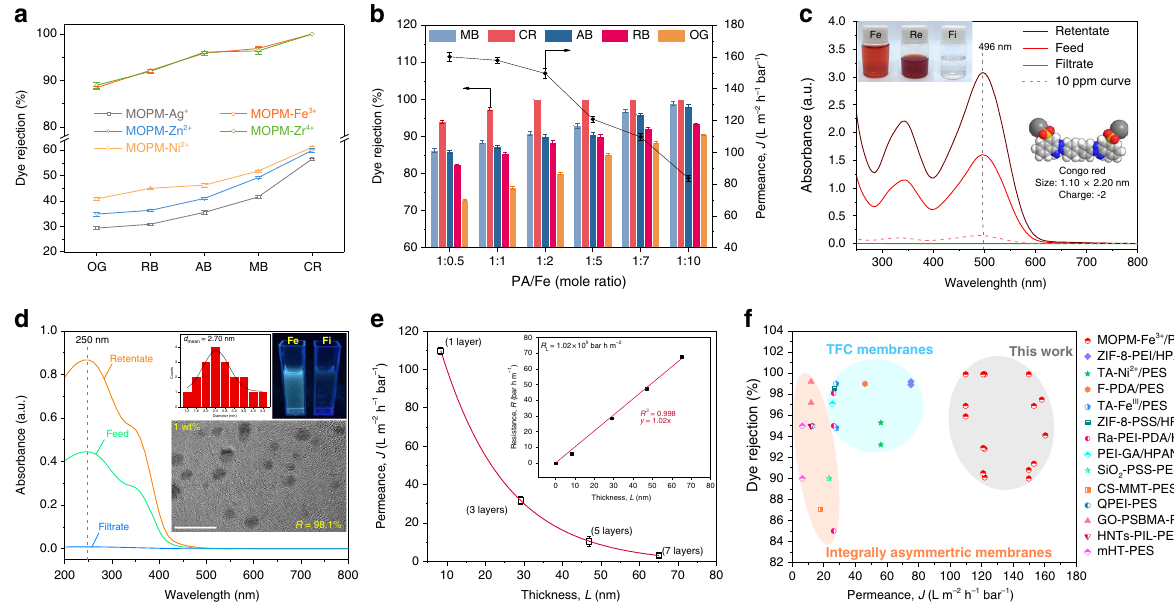
Fig. 3 Permselectivity of MOPM/PAN membranes. a , b Filtration performance of MOPM/PAN membranes with different coordinated metal ions ( a ) and MOPM-Fe 3 + /PAN membranes with varied PA/Fe ratio ( b ). 100 ppm of Methyl blue (MB, 1.62 × 2.03 nm), Congo red (CR, 1.10 × 2.20 nm), Alcian blue (AB, 1.42 × 2.20 nm), Rose Bengal (RB, 1.06 × 1.08 nm) and Orange GII (OG, 0.74 × 1.07 nm) solution as feed. c Ultraviolet-visible spectra of Congo red in feed, retentate, and fi ltrate. PA/Fe ratio = 1:7. Inset in c : Digital photo images of feed (Fe), retentate (Re) and fi ltrate (Fi) (top left) and molecular structure of Congo red (bottom right). d Ultraviolet-visible absorption spectra of graphene oxide quantum dots (GQDs) in feed, retentate, and fi ltrate. PA/Fe ratio = 1:0.5. Inset in d : Size distribution of GQDs (top left), digital photo images of feed (Fe) and fi ltrate (Fi) (top right) and TEM image of GQDs (bottom). Scale bar: 10 nm. e Water permeance of MOPM-Fe 3 + /PAN membranes with different layer number of MOPM-Fe 3 + . PA/Fe ratio = 1:7. Red line was the best exponential fi t. Inset in e : Mass transport resistance as a function of thickness for MOPM-Fe 3 + /PAN membranes with different skin layer thicknesses. Red line was the best linear fi t. f Filtration performance of state-of-the-art polymeric membranes for water puri fi cation in literatures. Error bars represent standard deviations for 3